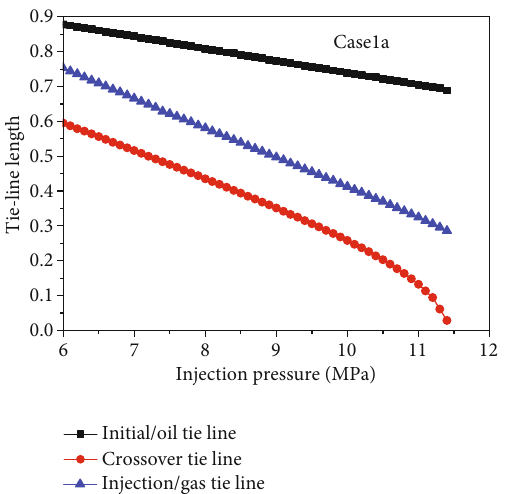
Figure 3: Variation of key tie-line lengths vs. pressure for Case 1a. The MMP was estimated to 11.46MPa (1662psia).